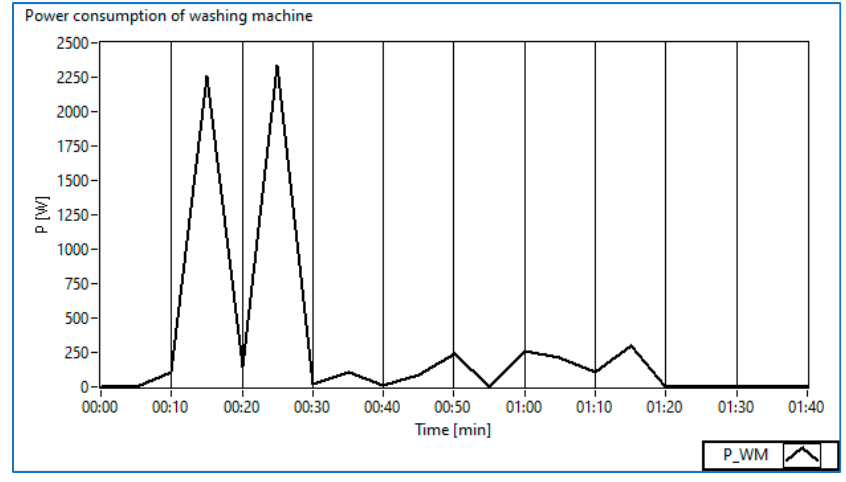
Figure 2. Power consumption (P_WM) during an operation cycle for washing machine.